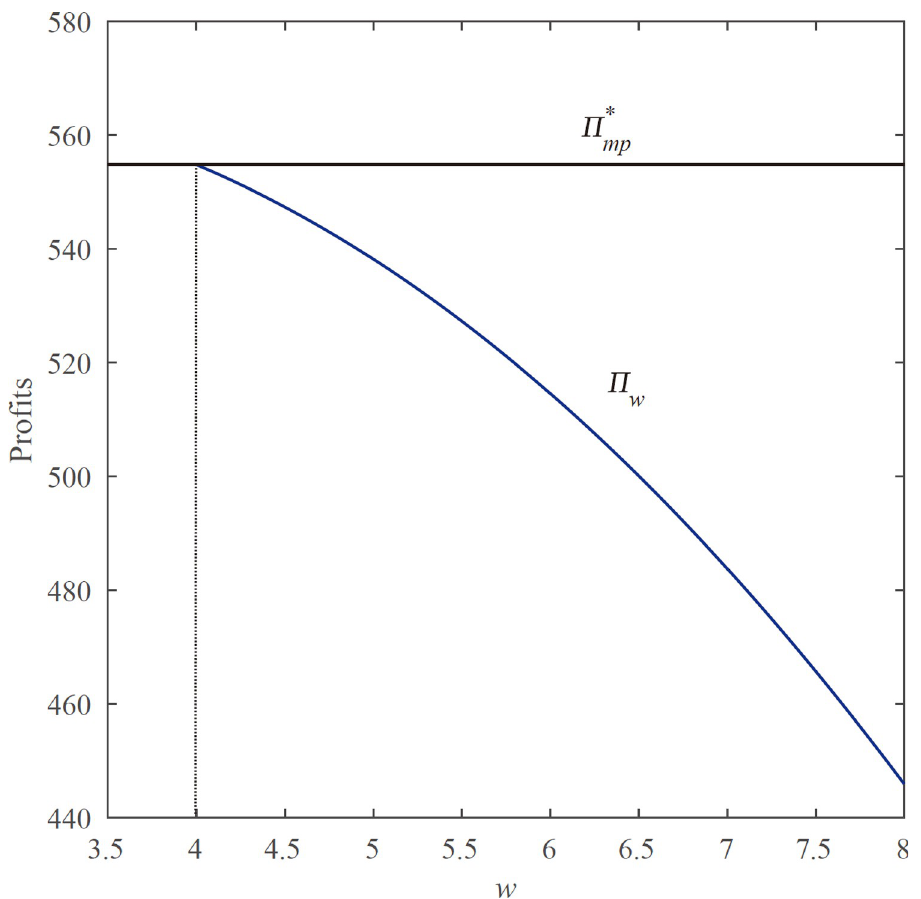
Fig 2. Comparison of the profit function of Π � parameter values are p s = 15 , p o = 11 , c o = 5 , c s = 4 , θ = 0.5 , h o = 3 , and h s = 1 .